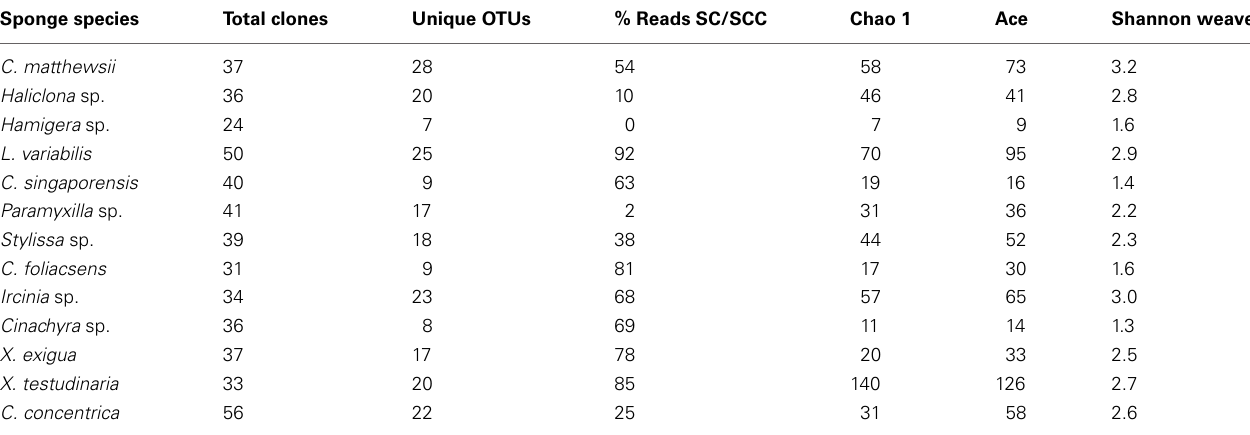
Table 4 | Diversity indices calculated from sequences of 16S rRNA genes using a 97% sequence similarity threshold. Sponge species